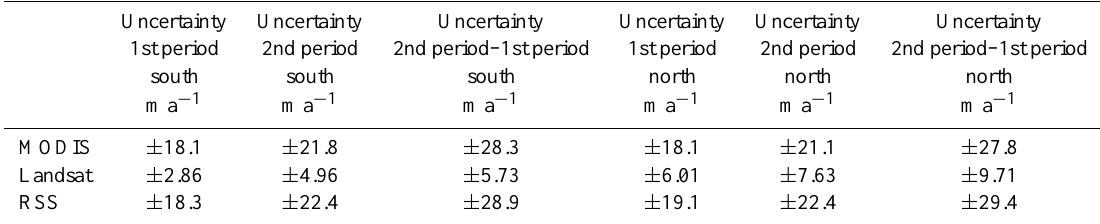
Table 4. Uncertainty of the measured MODIS and Landsat displacements and accelerations. The root sum square (RSS) of the uncertainties are also given and can be compared with the deviations given in the lower row of Table